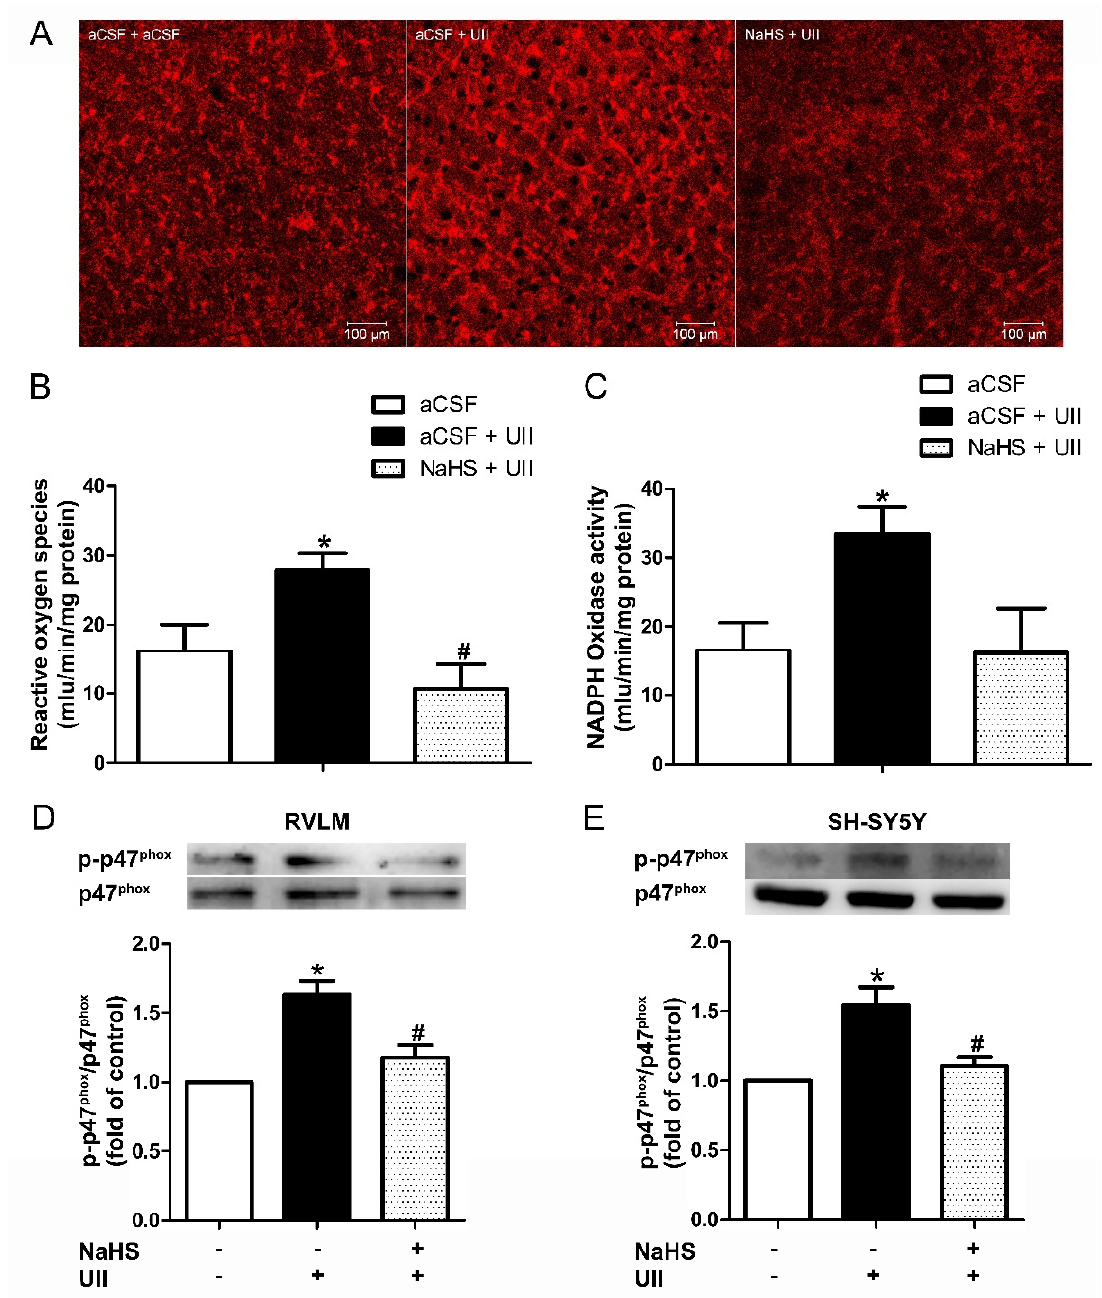
Figure 5. Microinjection of NaHS (400 pmol/0.1 μ L) into the RVLM suppressed UII − induced super- oxide production rise in SD rats. Representative images of reactive oxygen species (ROS) levels as assessed by dihydroethidium (DHE) staining in brain slices from RVLM ( A ). Tissue levels of super- oxide anion ( B ) and NADPH oxidase activity ( C ) after microinjection of aCSF ( n = 6, 4), aCSF + UII ( n = 6, 4), or NaHS + UII ( n = 6,4). The change in p − p47 phox after microinjection of aCSF ( n = 6), aCSF + UII ( n = 6), or NaHS + UII ( n = 6) into the RVLM of SD rats ( D ). The change in p − p47 phox after pretreated with NaHS (50 μ mol/L) for 30 min before UII (10 − 8 mol/L) was used ( E ). * p < 0.05 vs. aCSF group; # p < 0.05 vs. aCSF + UII group.